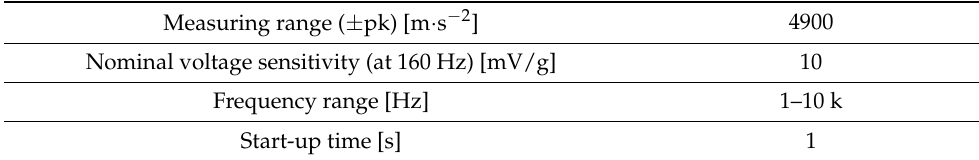
Table 1. Selected technical parameters of the Bruel & Kjaer 4514-B